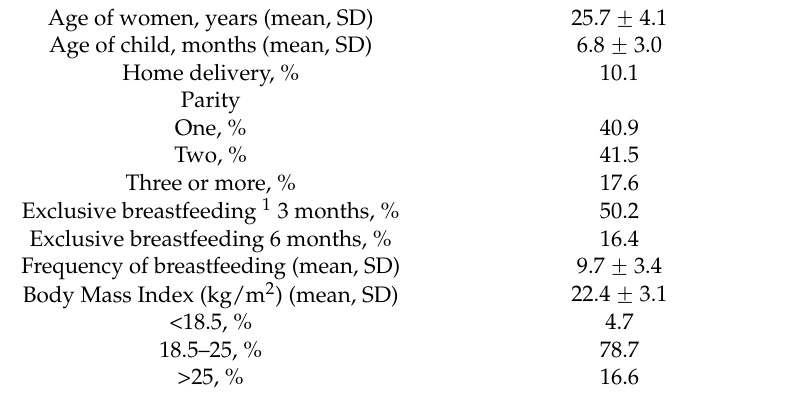
Table 1. Background data on the lactating Nepali women ( n = 485).